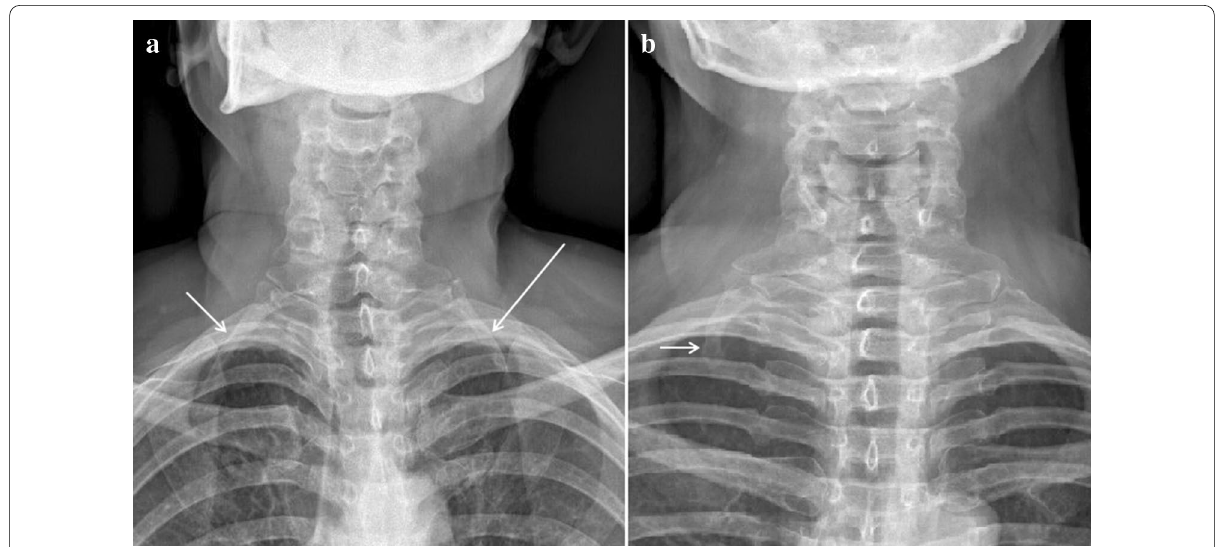
Fig. 1 TOS. Standard chest X-ray. Patient with bilateral cervical ribs: a right (short arrow) and left (long arrow) cervical rib. Patient with unilateral cervical rib: b right cervical rib (arrow)